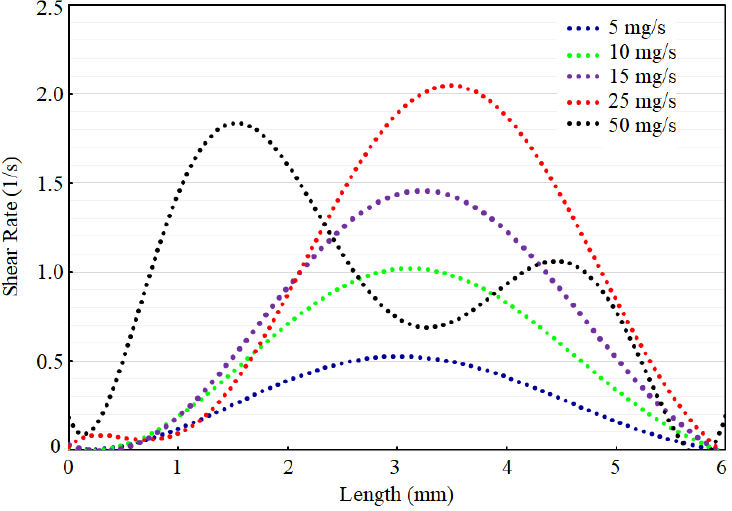
Figure 18. The change in shear rate for different values of inlet mass flow rate condition along the centerline of the